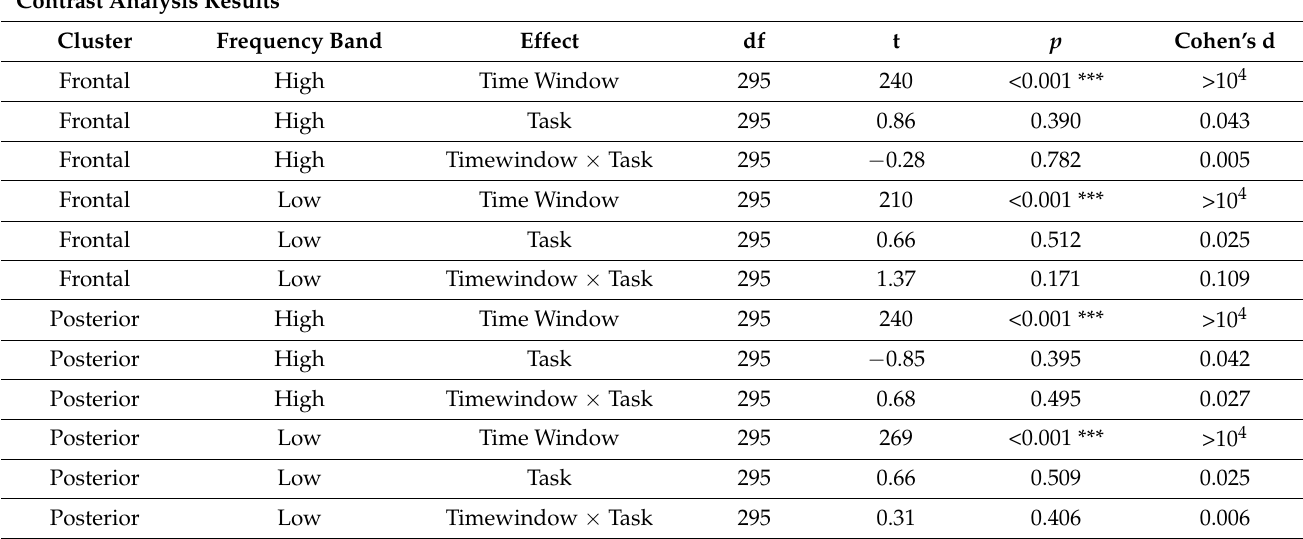
Table 2. Results from the task × time window linear mixed model analysis using the focused contrasts across the different electrode clusters and frequency bands. Note that for the effect of tasks, we only tested the narrow hypothesis that Active WM+ led to a higher PLV than the other two conditions. When marking significance, *** denotes p <